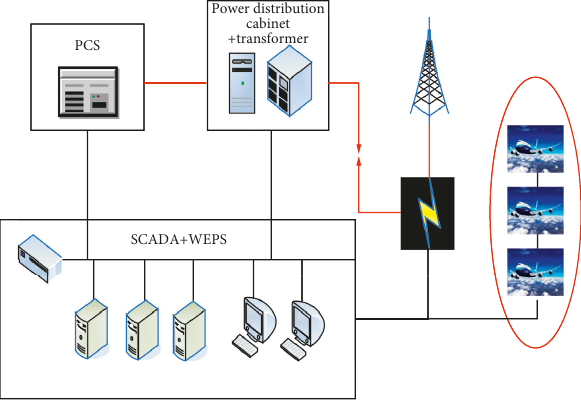
Figure 1: Energy storage type electric field architecture